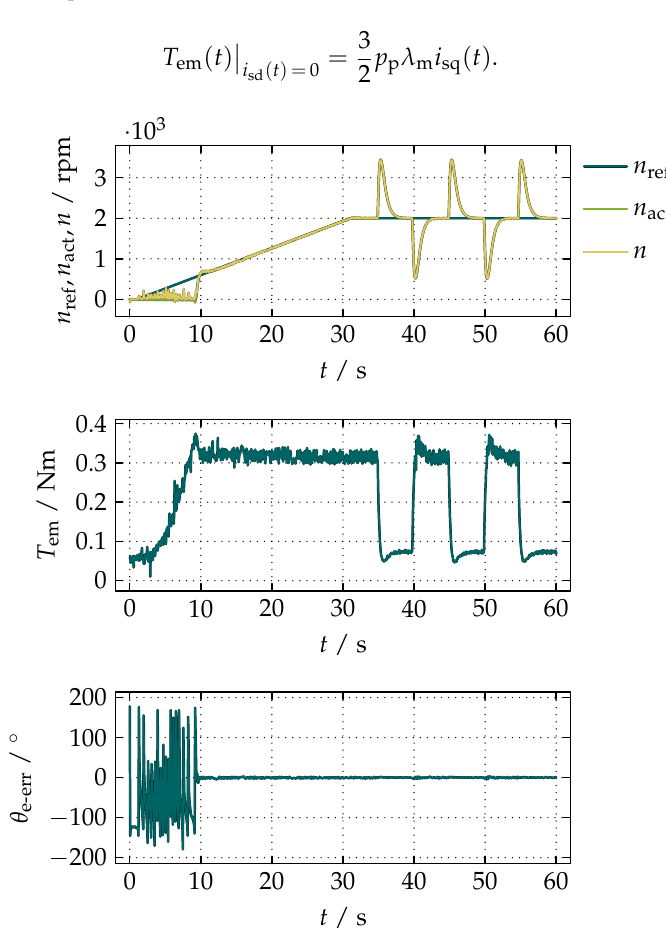
Figure 16. Acceleration from 0 rpm to 2000 rpm under the constant load torque of 90% of T n until intermittent periodic loading at 2000